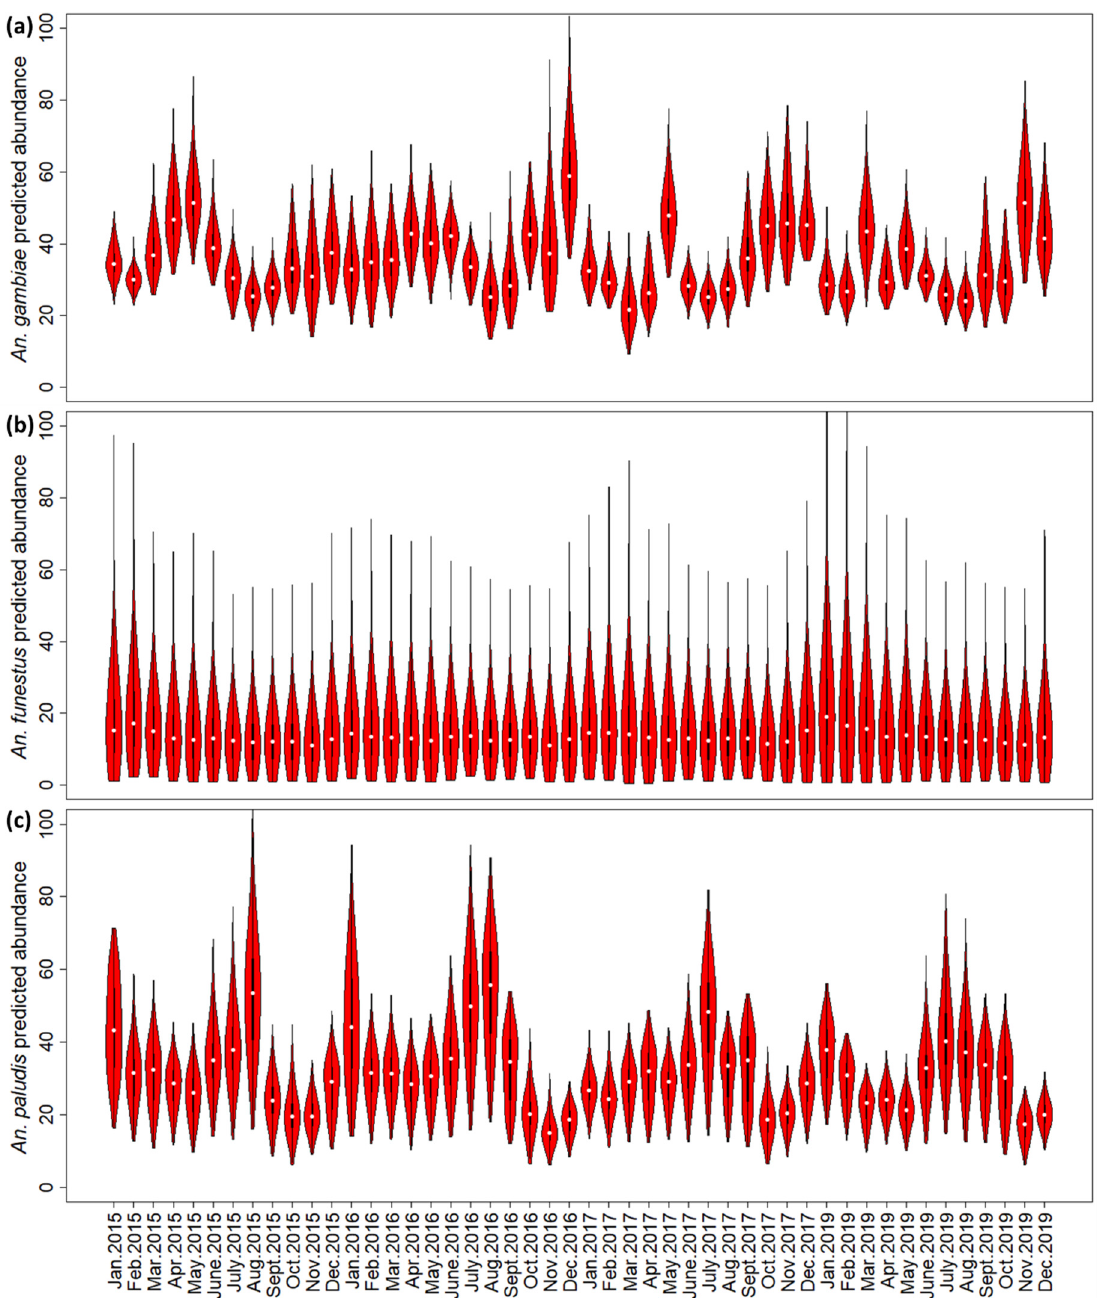
Figure 10. Violin plot displaying the distribution of mosquito abundances for all buildings of Lodja for ( a ) An. gambiae s.l. ; ( b ) An. funestus; and ( c ) An. paludis .